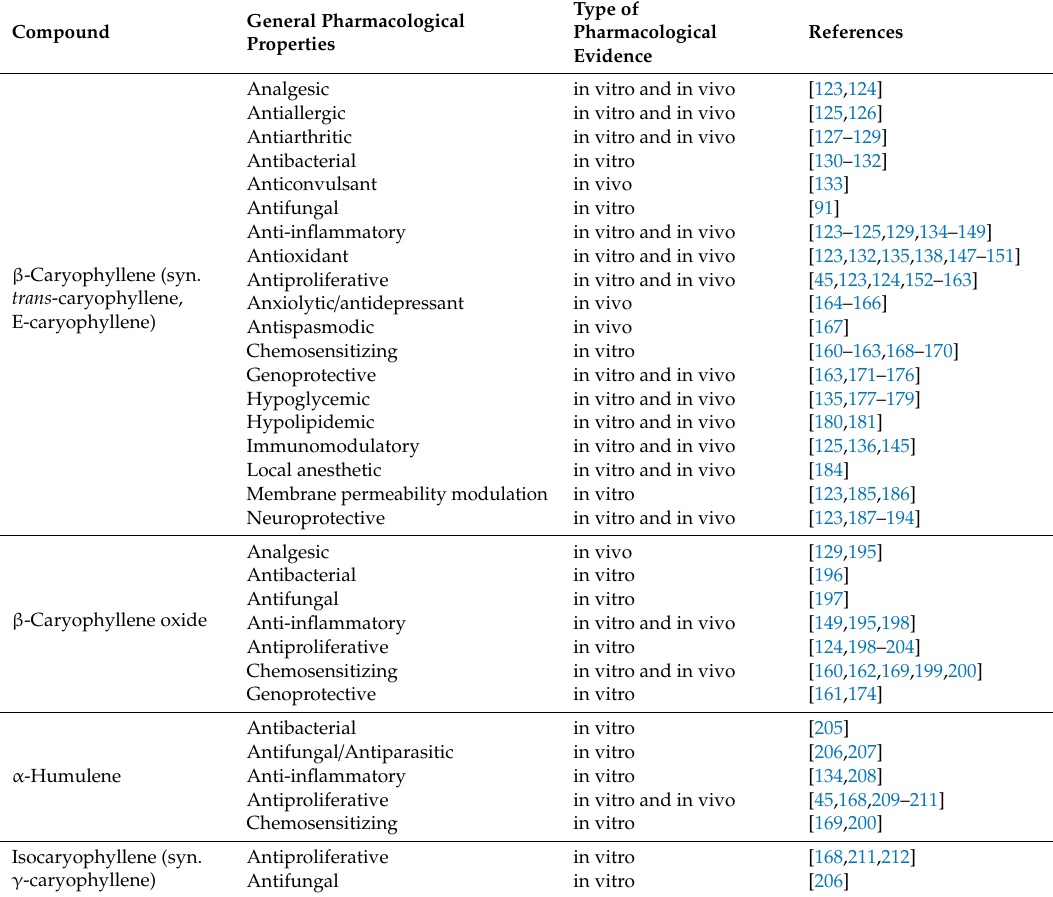
Table 3. Pharmacological activities found for the caryophyllane sesquiterpenes identified in plant essential